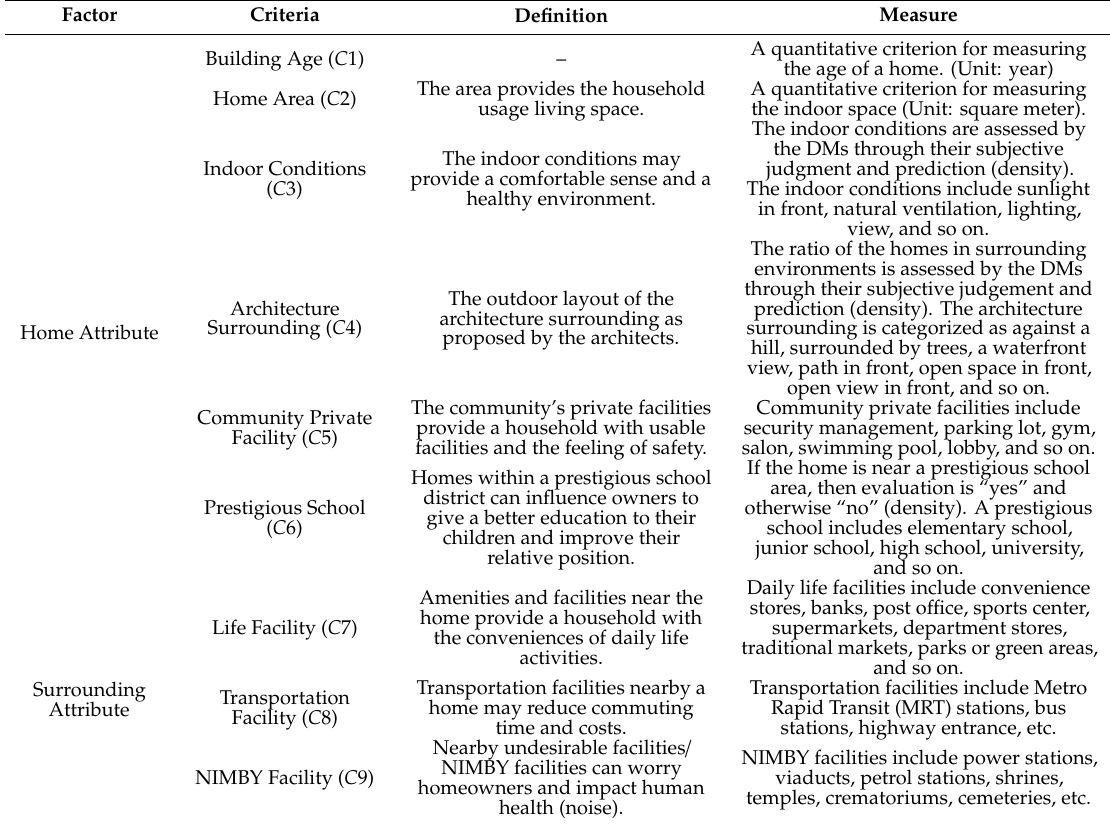
Table 4. Definitions of decision criteria and utility function types.